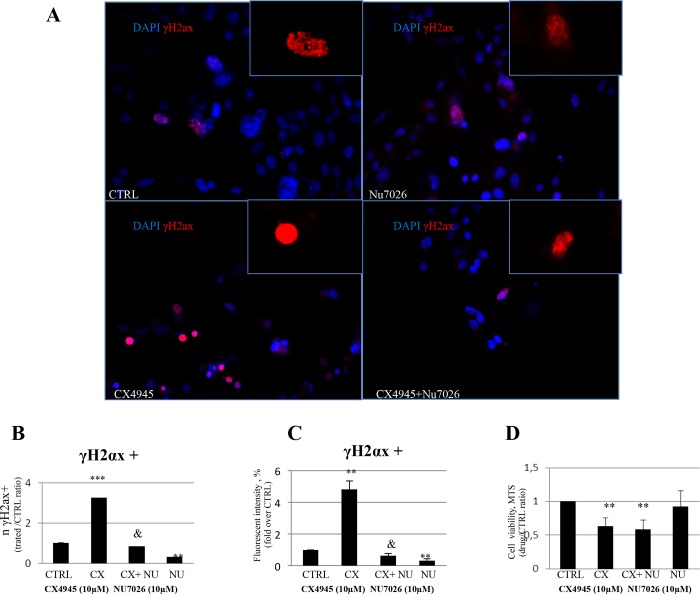
Immunofluorescence for γH2ax and MTS assays.A-C: mucin-IHCCA primary cell cultures were investigated by IF for γ-H2ax nuclear foci, a biomarker of DNA double-strand breaks. After 72hrs of treatment, CX4945 (10μM) increased the number of γ-H2ax positive (red) nuclei vs control. A potent DNA-PK inhibitor (NU7026, 10 μM) reduced γ-H2ax positive nuclei as indicated by fluorescent intensity vs controls and blocked the effects of CX4945 on γ-H2ax ** = p<0.01 vs other columns;*** = p<0.001 vs other columns; & = p<0.01 vs CX4945 and NU7026 alone. D: NU7026 alone or in combination with CX4945 failed to influence cell viability in mucin-IHCCA cultures vs control and CX4945 alone.** = p<0.01 vs control and NU7026 alone. Mean +/-SD of N = 3–5 independent experiments.